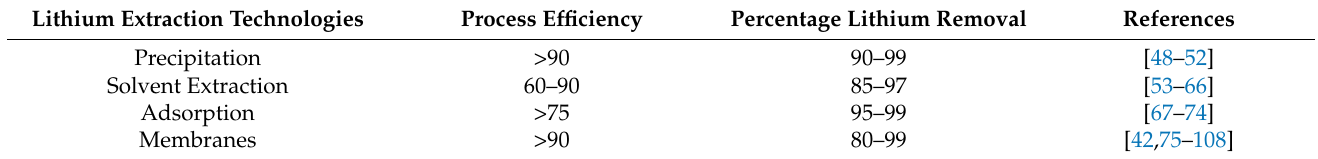
Table 2. A comparison of the process efficiency and percentage lithium removal from conventional